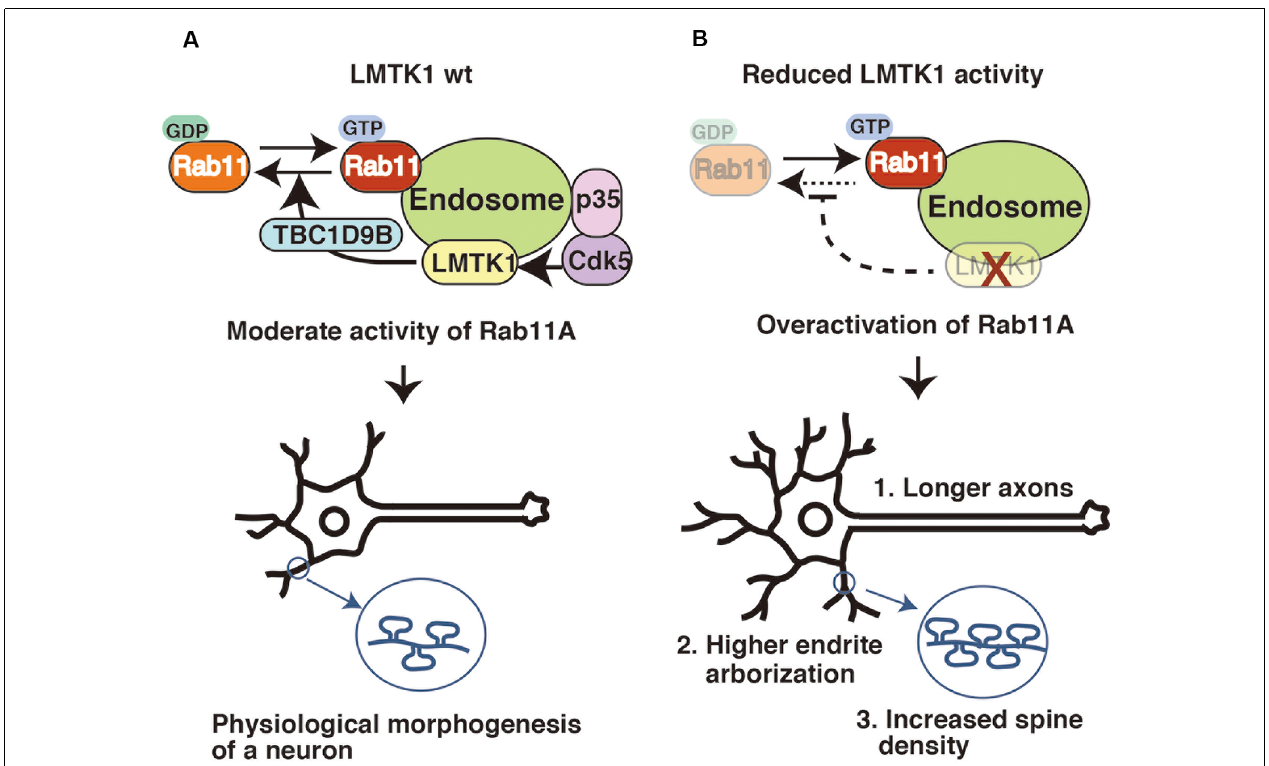
FIGURE 3 | LMTK1 regulates axon outgrowth, dendrite arborization, and spine density through TBC1D9B Rab11 GAP. (A) The proper regulation of Rab11A is important for controlling the morphogenesis of neurons. The Cdk5-LMTK1A-TBC1D9B pathway is the upstream cascade of Rab11A endosomal regulation. Cdk5/p35 regulates LMTK1A activity by phosphorylation. LMTK1 activates TBC1D9B, leading to the inactivation of Rab11A activity. This regulation cascade operates on the endosome. (B) Downregulation of LMTK1 results in overactivation of Rab11A, leading to: (1) overgrowth of axons; (2) higher dendrite arborization; and (3) excessive dendritic spine